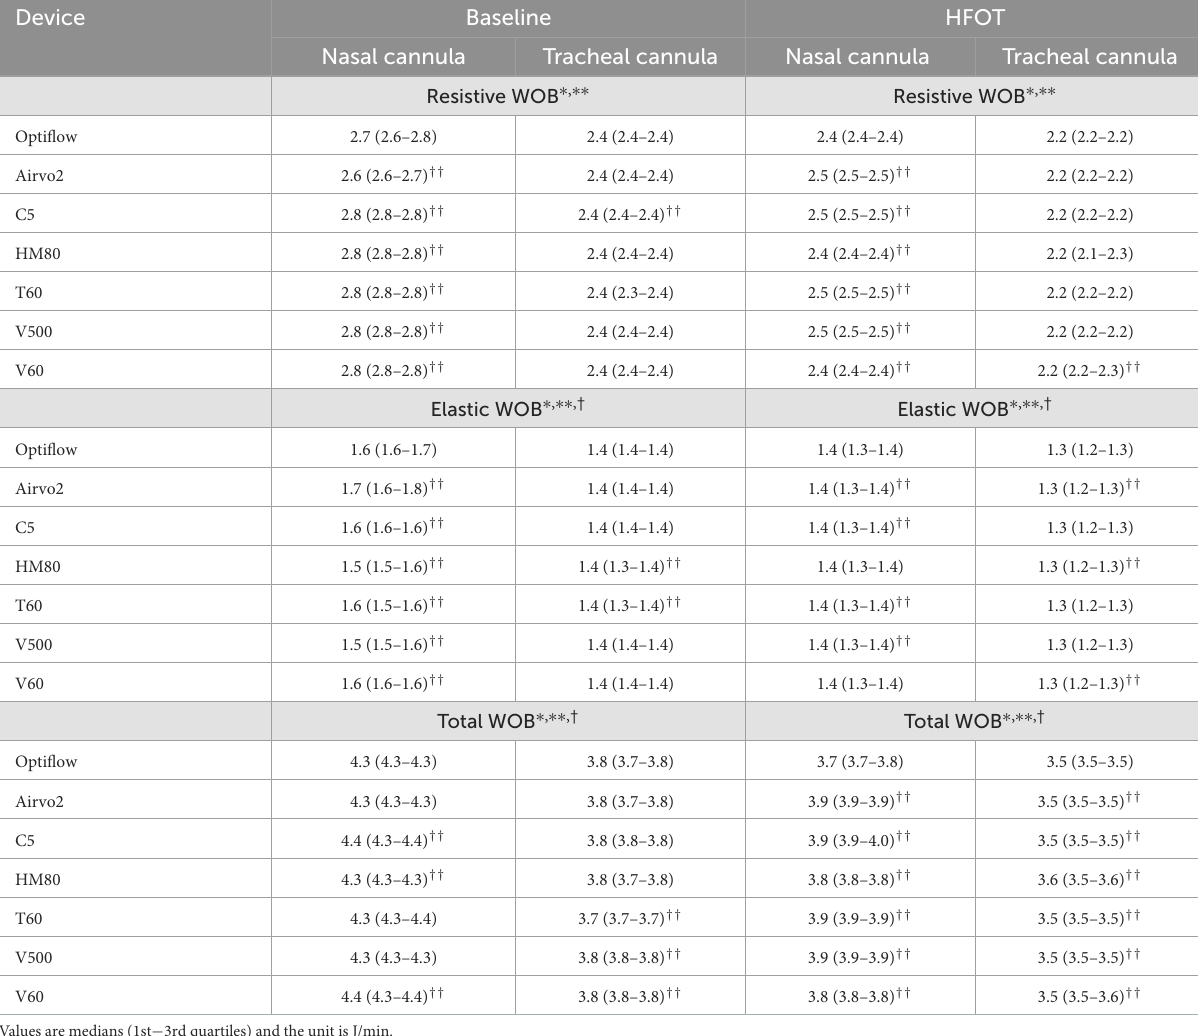
TABLE 1 Work of breathing between devices and cannulas at baseline and under high flow oxygen therapy.